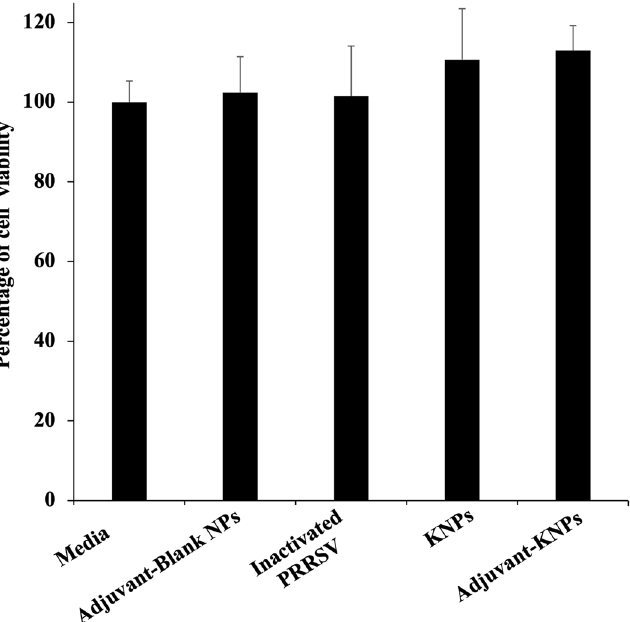
Figure 2. Effects of the various treatments on the viability of PAMs. Cells were treated with inactivated PRRSV, adjuvant-blank NPs, KNPs and adjuvant-KNPs. Cell viability was analyzed using the MTT assay, and each sample was analyzed in